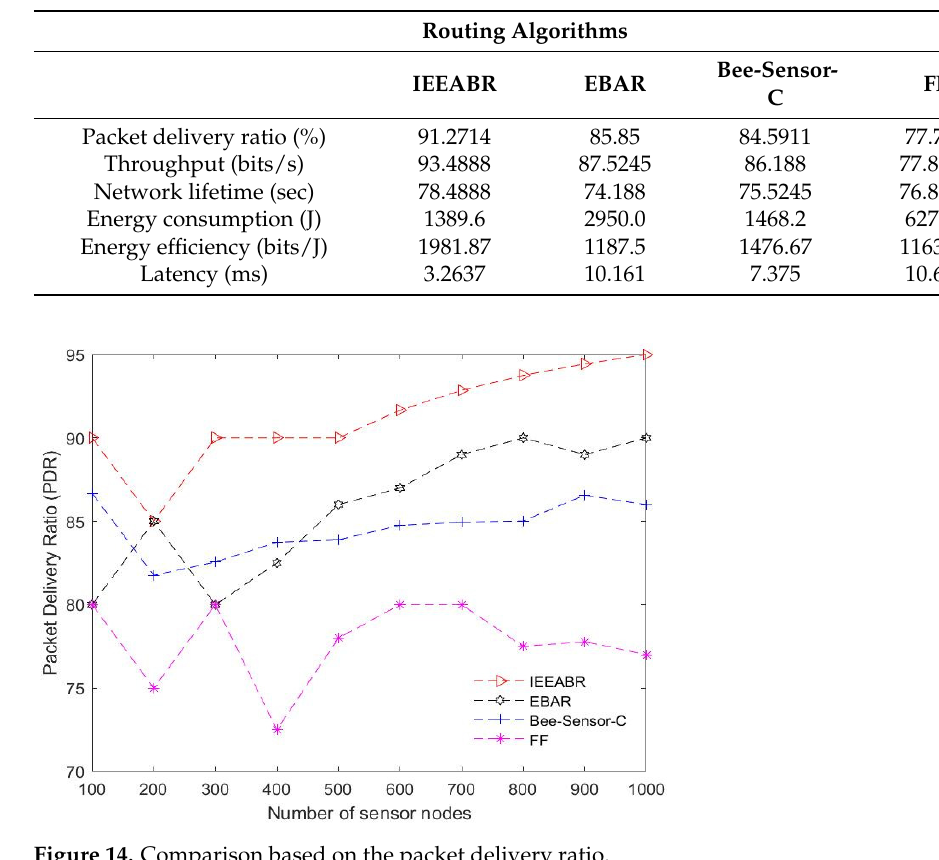
Figure 16. Comparison in terms of network lifetime.